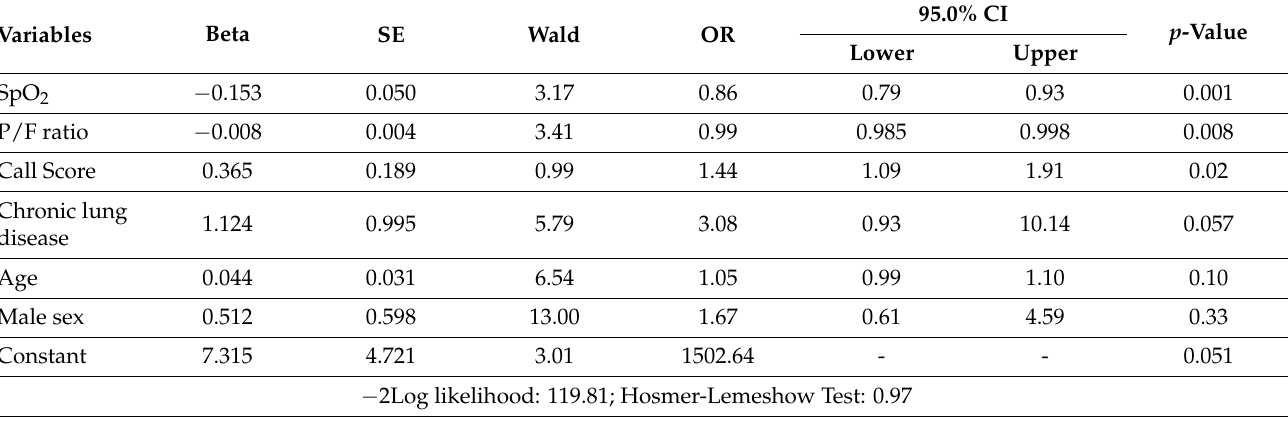
Table 3. Multivariable logistic regression for the risk of CPAP failure. Post-IPTW population.